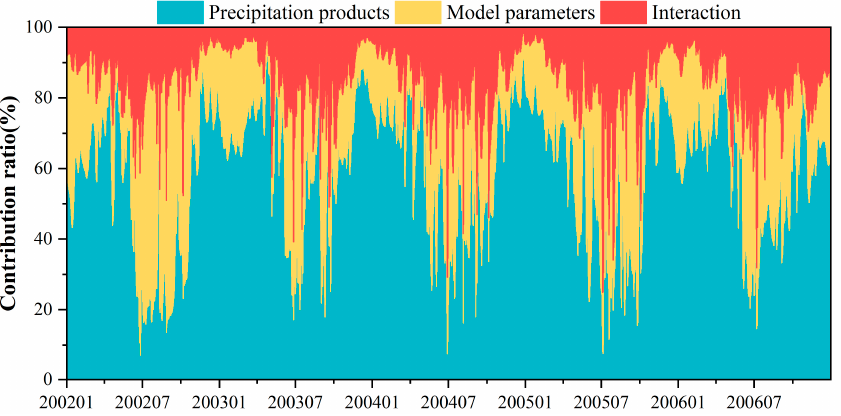
Figure 10. The contribution ratio (%) of the precipitation products, model parameters, and their interaction to the total uncertainty of the streamflow simulation at the daily scale.